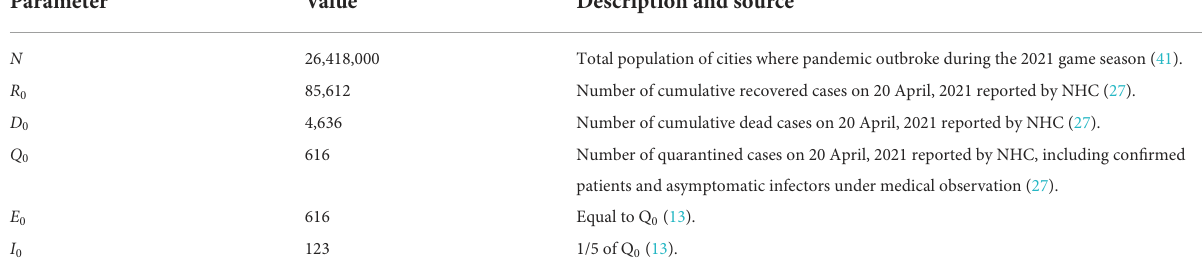
TABLE 1 Parameters in the SEIR